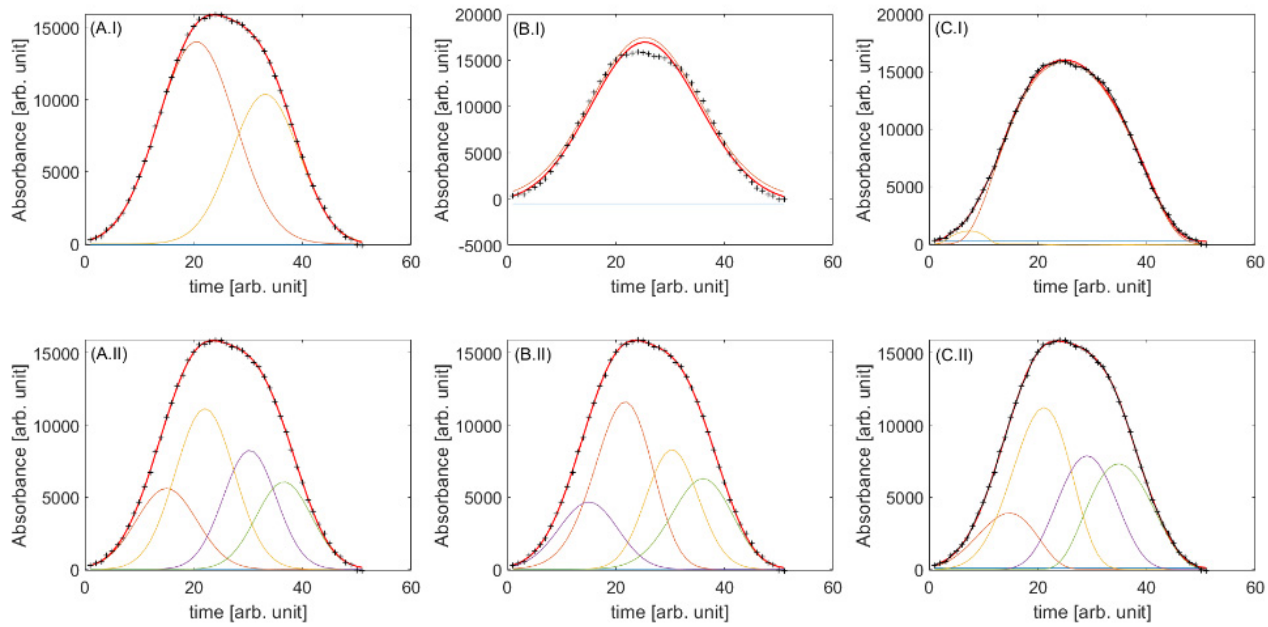
Figure 2. D1nh experimental data (black crosses), fitted signals (red lines) and deconvolved components using the iterative multivariate peak fitting approach: ( A.I , B.I , C.I ) first-order data (mean profile) fitted with a Gaussian, PMG1 and PMG2 mathematical functions. ( A.II , B.II , C.II ) second-order data fitted with a Gaussian, PMG1 and PMG2 mathematical functions.